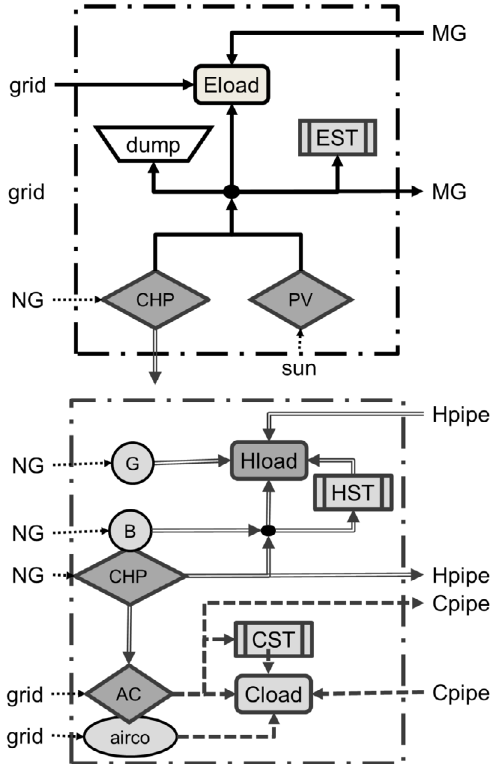
Fig. 2. Black-box diagram of energy supply options. AC, absorption chiller; B, boiler; CHP, micro combined heat and power unit; Cpipe, cooling pipeline; G, gas heater; MG, microgrid electricity sharing; Hpipe, heating pipe; PV, photovoltaic unit; Dump, dump load; CST, cold storage unit; EST, electrical storage unit; HST, hot storage unit; NG, natural gas; Cload, cooling load; Eload, electrical load; Hload, heating load